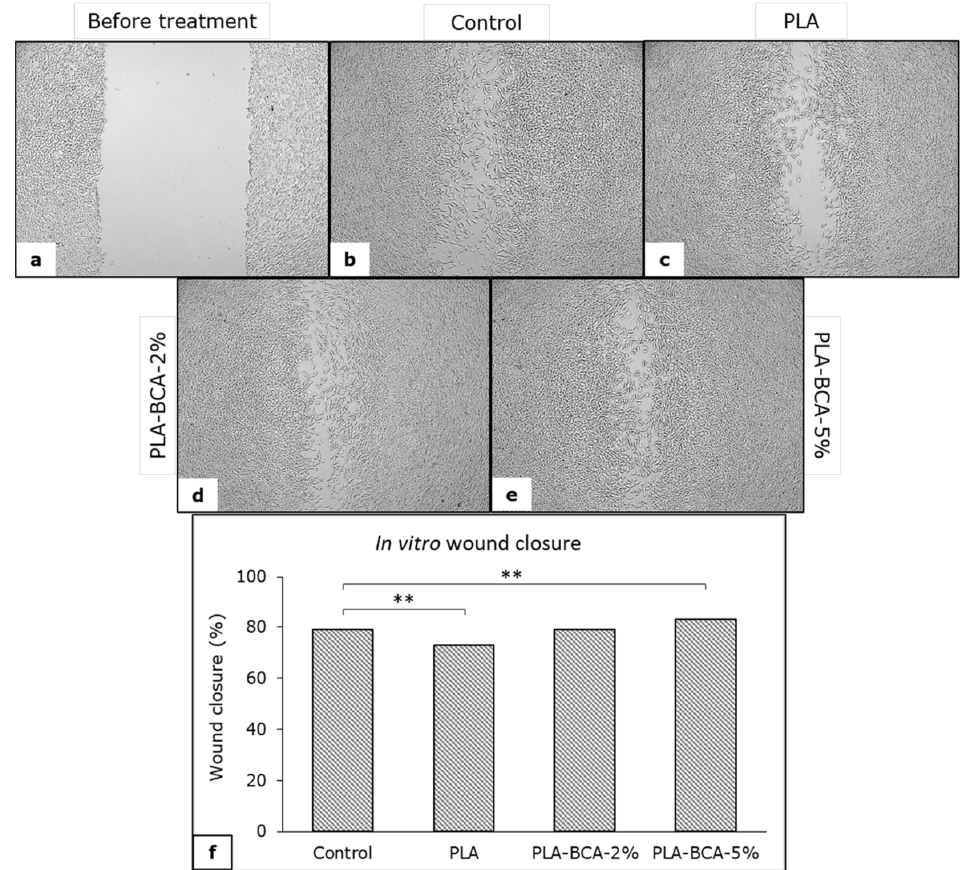
Figure 9. Appearance of in vitro created “wounds” before ( a ) and three days after incubation with complete medium (control) ( b ), PLA ( c ), PLA-BCA-2% ( d ) and PLA-BCA-5% ( e ); as well as percentage of wound closure ( f ); (**) p < 0.01.